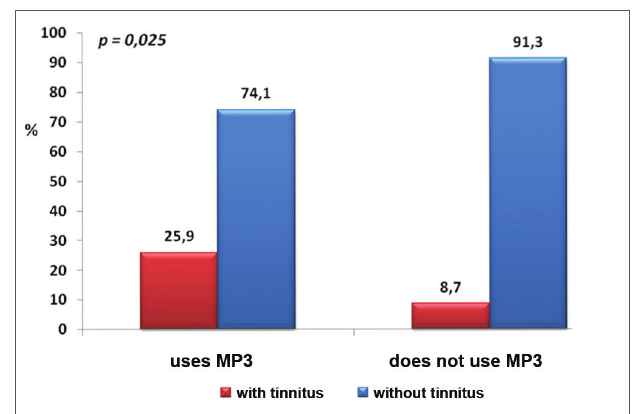
Figure 1. Incidence of tinnitus in both